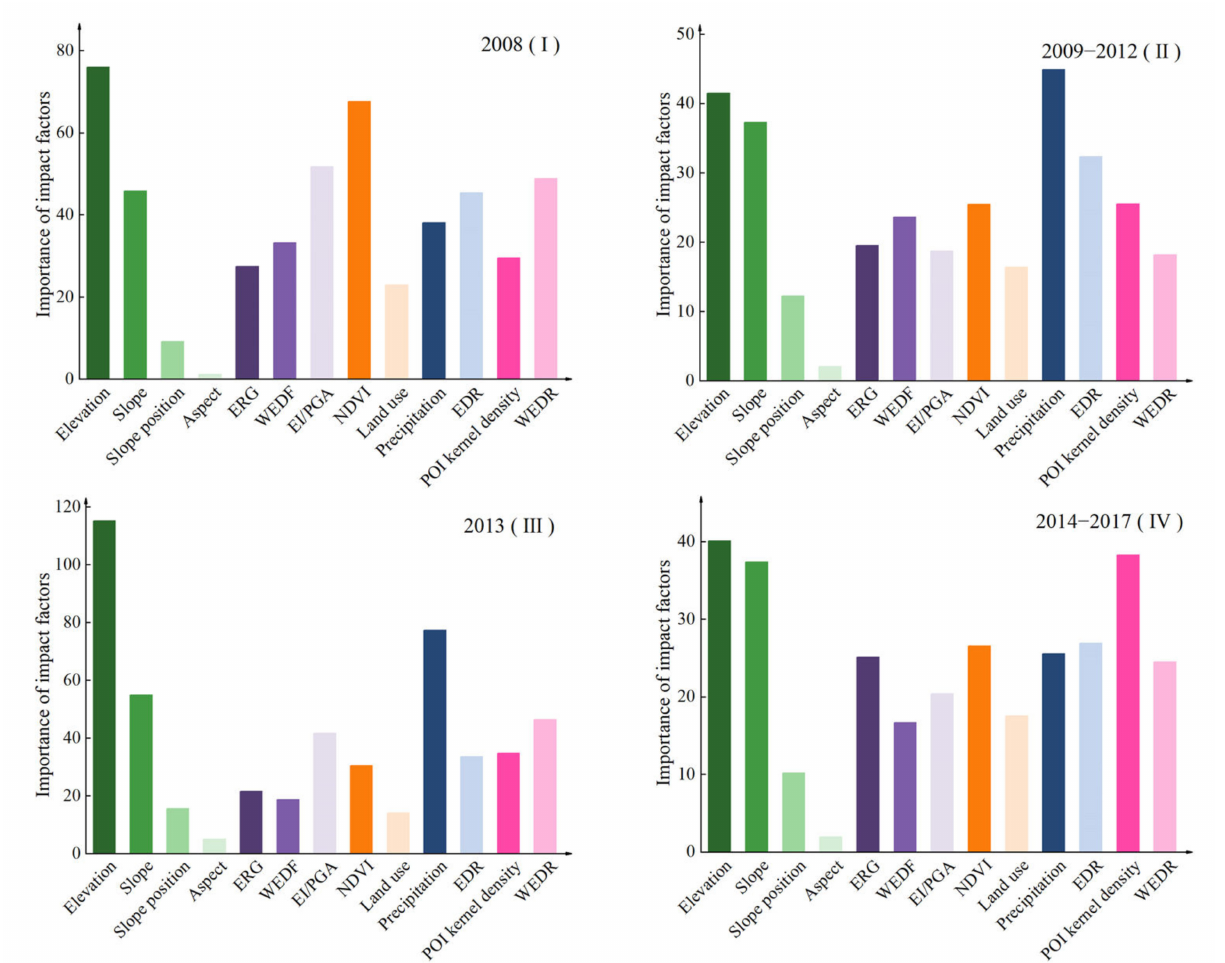
Figure 8. Importance of impact factors in four